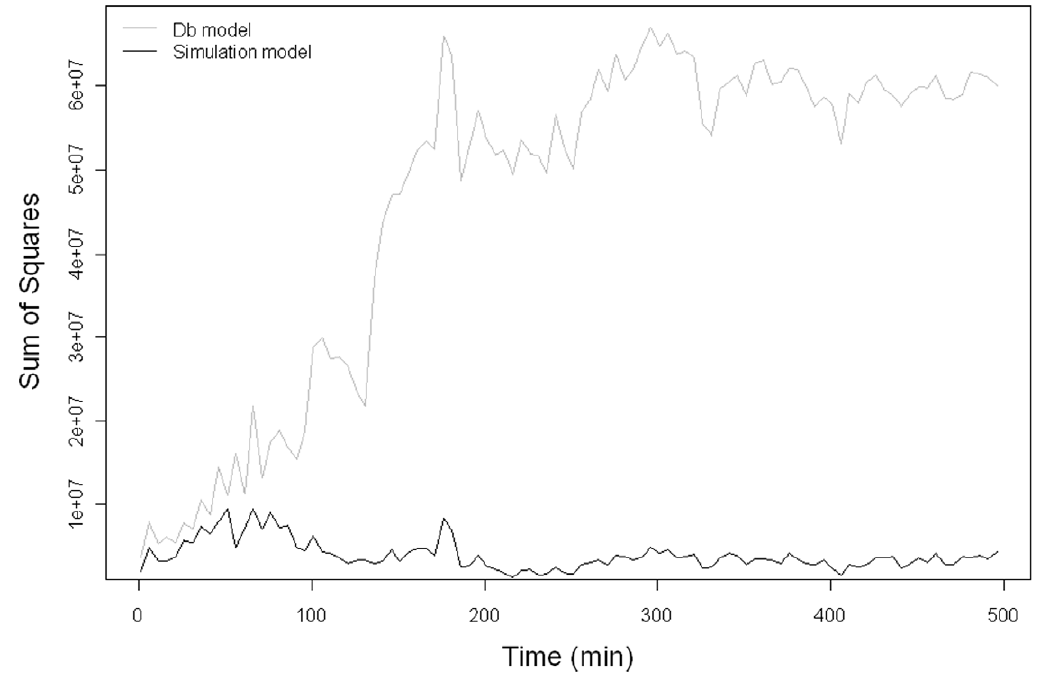
Figure 6. The sum of squares (measure of fit) of the commonly used Db model (grey) and the simulation model (black) over time. We acknowledge that alternative models of bioturbation (not presented here) may also show a better measure of fit than the Db model, but provide this comparison as Db is often the preferred model in empirical investigations using bioturbation as a response variable.